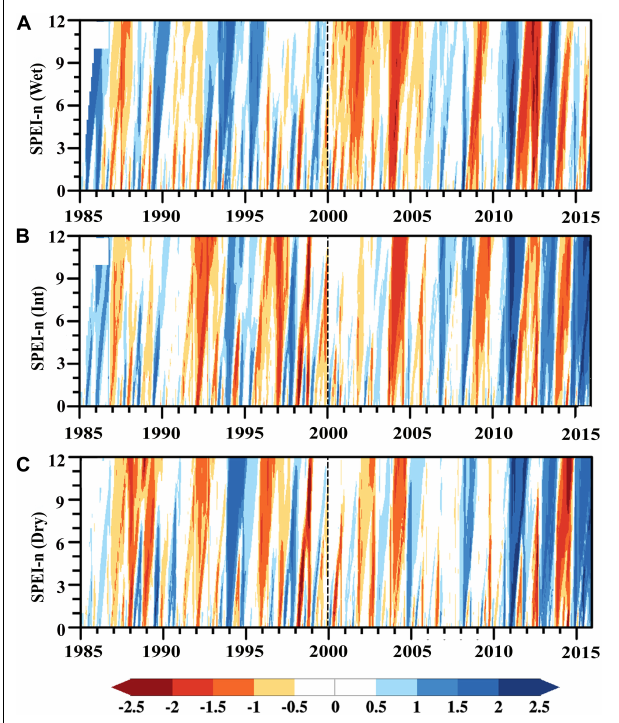
FIGURE 4 | Hovmoller-type diagram for the temporal variation of the SPEI at different timescales (from 1 to 12 months) for (A) wet (B) intermediate, and (C) dry regions in Mahaweli river basin (MRB) from 1985 to 2015. The black dash line separates early (P 1 ;1985–1999) and late (P 2 ;2000–2015) periods. The letter Wet, Int, and Dry represent wet, intermediate, and dry regions in MRB, respectively.